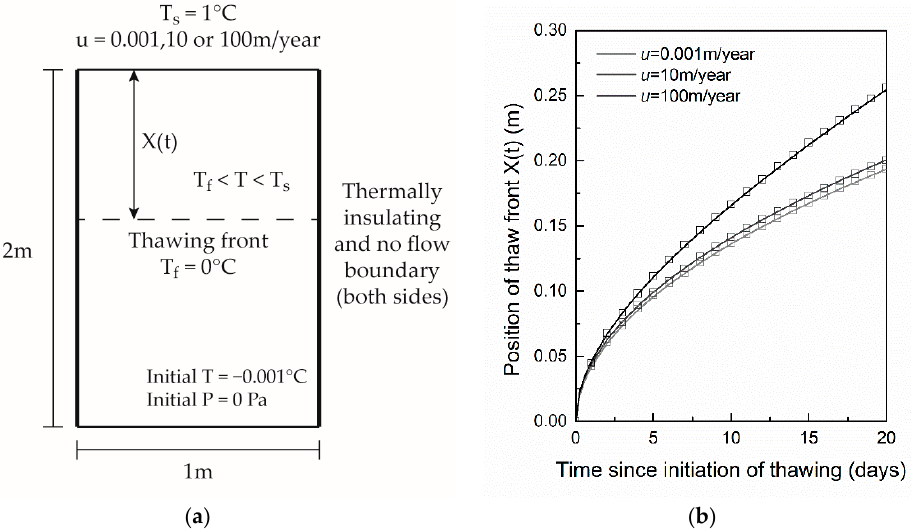
Figure 3. Comparison of the results of analytical and numerical solutions. ( a ) Model geometry, initial conditions and boundary conditions employed in COMSOL; and, ( b ) position of the thawing front versus time at three Darcy velocities: 0.001 m/year (light gray, negligible advection), 10 m/year (medium gray), and 100 m/year (black) calculated by Lunardini’s analytical solution (lines) and numerical solution (squares).